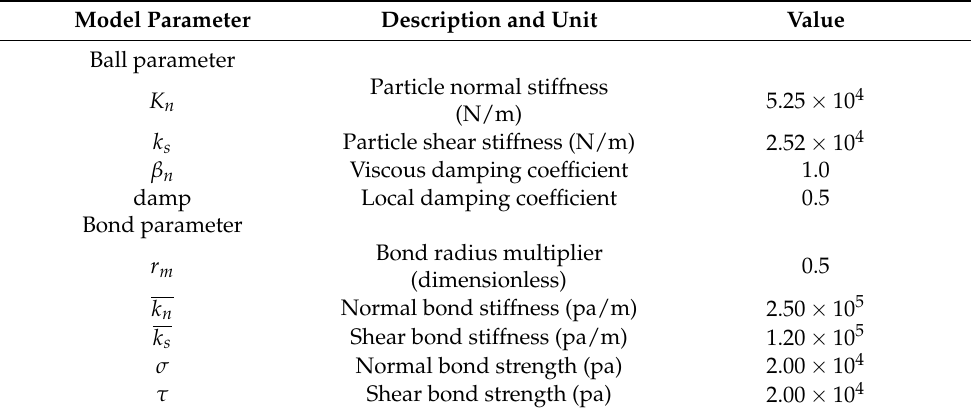
Table 1. Model input parameters taken from Nandanwar and Chen